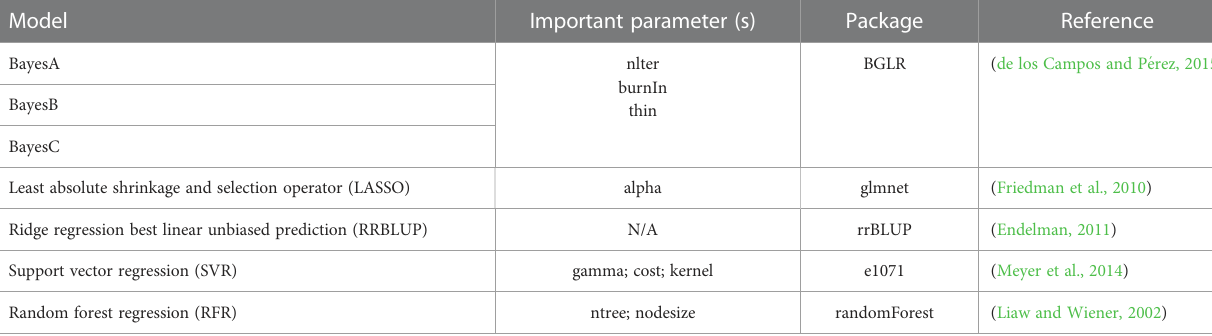
TABLE 1 Seven GS methods integrated into